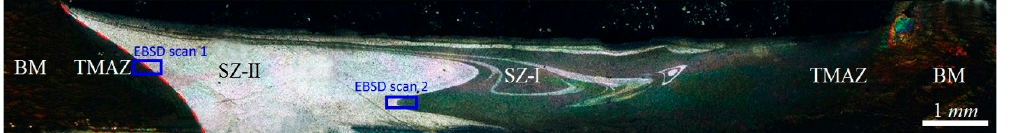
Figure 9. Inverse pole figure maps of the area indicated by rectangle 2 in Figure 7. Higher magnification of zones 1 and 2 indicated in ( a ) are illustrated in ( b ) interfacial area between TMAZ and SZ-II and ( c ) SZ-II, respectively.